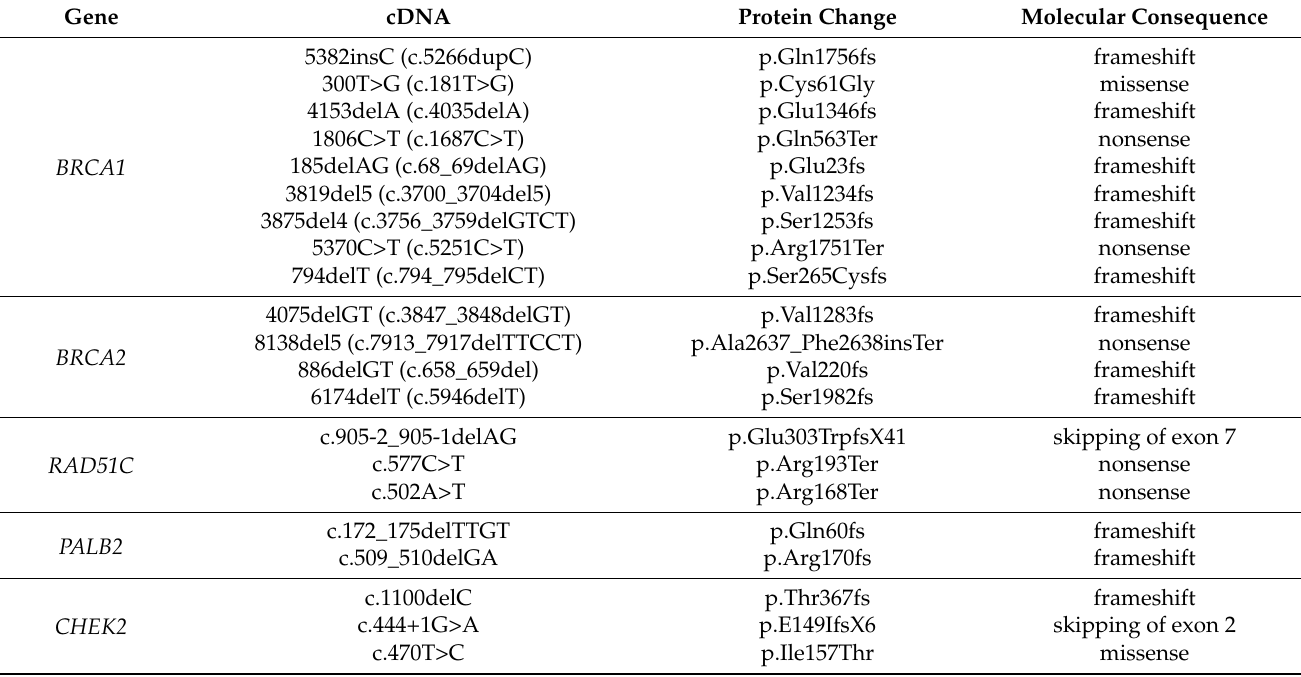
Table 5. Recurrent mutations tested in BRCA1 , BRCA2 , RAD51C , PALB2 , and CHEK2 genes. Gene cDNA Protein Change Molecular